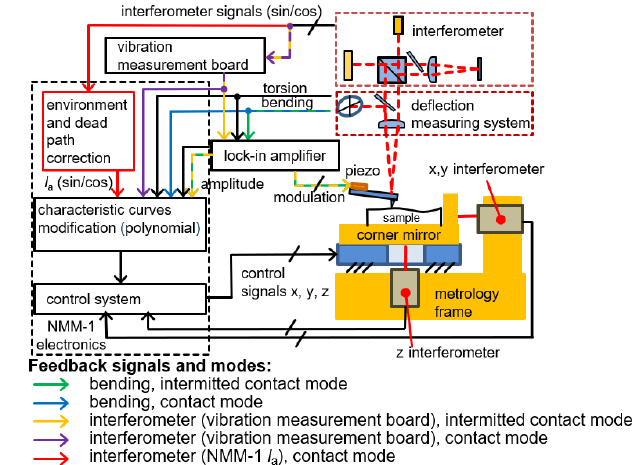
Figure 6. Schematic diagram for the signals of the MAFM system in the different modes.